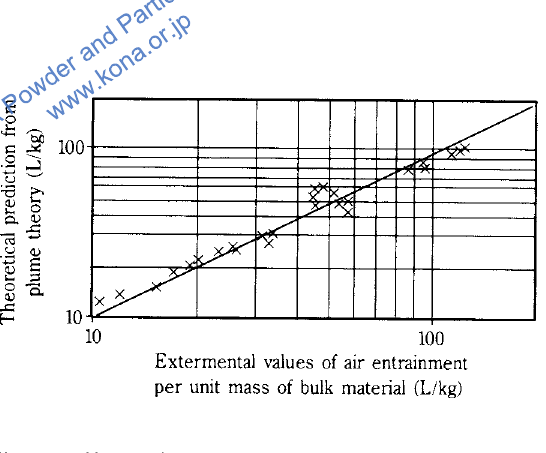
Fig. 11. Air entrainment predicted from simple plume theory against measured values (entrainment constant =